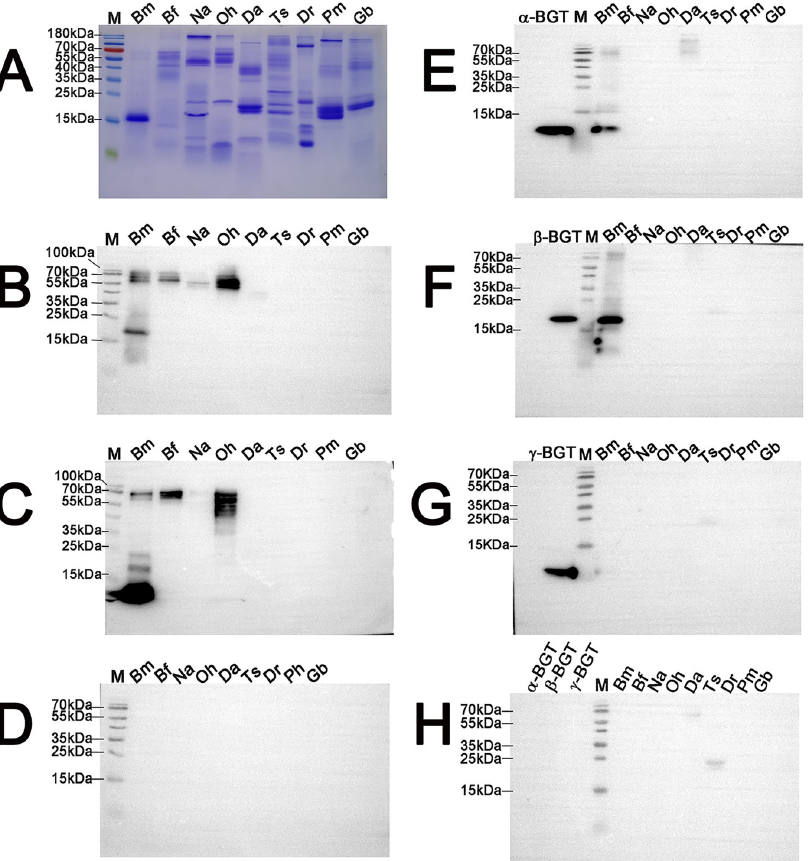
Fig 4. Immunoreactivity of the commercial B . multicinctus antivenin and the prepared antiserum against top Chinese dangerous terrestrial snake venoms. SDS-PAGE of nine used snake venoms under non-reducing conditions, 25 μ g/sample (A). Western blot revealed by B . multicinctus antivenin under non-reducing conditions (B). Western blot revealed by B . multicinctus antivenin under reducing conditions (C). Western blot revealed by normal horse IgG under non-reducing conditions (D). Western blot revealed by prepared anti- α -BGT antiserum under non-reducing conditions (E). Western blot revealed by prepared anti- β -BGT antiserum under non-reducing conditions (F). Western blot revealed by prepared anti- γ -BGT antiserum under non-reducing conditions (G). Western blot revealed by normal rabbit IgG under non-reducing conditions (H). Bm: B . multicinctus ; Bf: B . fasciatus ; Na: N . atra ; Oh: O . hannah ; Da: D . acutus ; Ts: T . stejnegeri ; Dr: Daboia russelii siamensis ; Pm: P . mucrosquamatus ; Gb: G . brevicaudus . 10 μ g/sample was loaded for Western blot experiments.